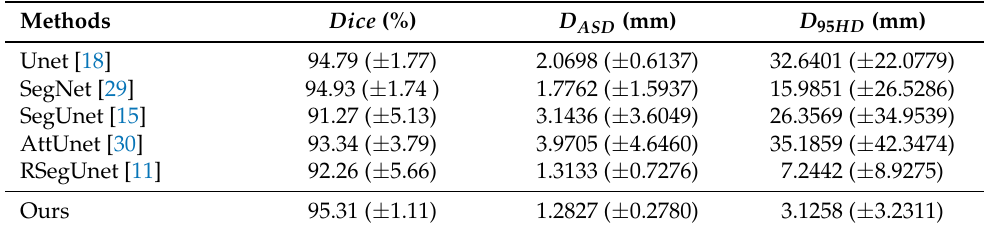
Table 1. Quantitative comparison of segmentation performance for the CBCT dataset between the proposed method and the state-of-the-art methods.